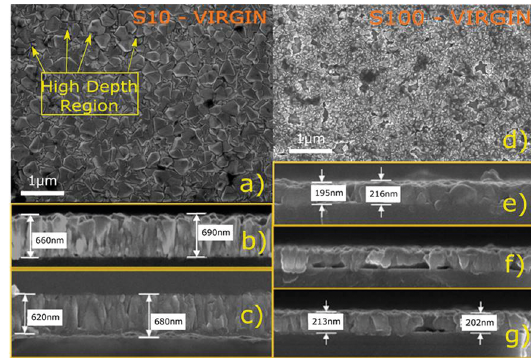
Figure 5. Scanning Electronic Microscopy. a) Top View of the surface of sample S10 with presence of High Depth Region or